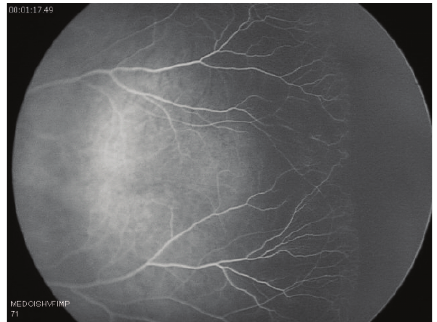
Figure 2: Fluorescein angiogram of the left eye at 1 minute and 17 seconds revealing peripheral